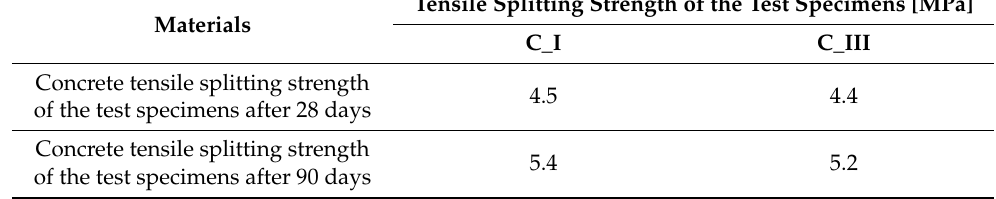
Table 8. Influence of the type of cement on the tensile splitting strength of the test specimens after 28 and 90 days.